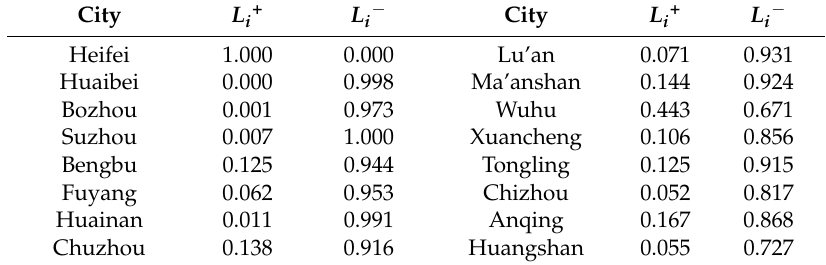
Table 6. Distance between the sustainability of each city and the positive and negative ideal